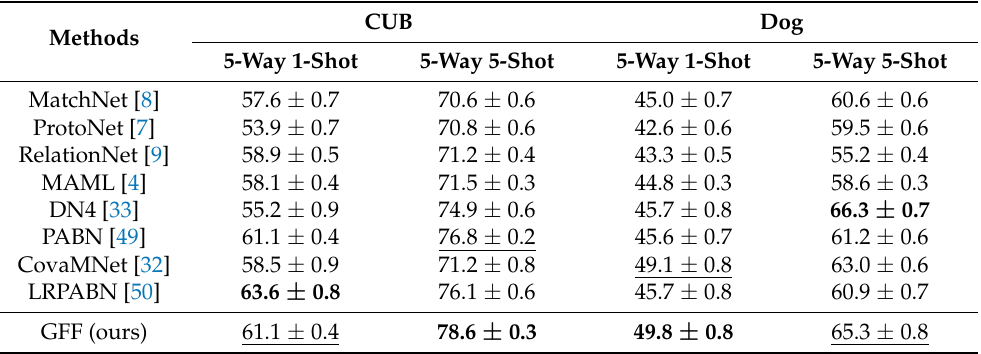
Table 5. Classification accuracies (%) with different methods in the 5-way K-shot cases on CUB and DOGS.